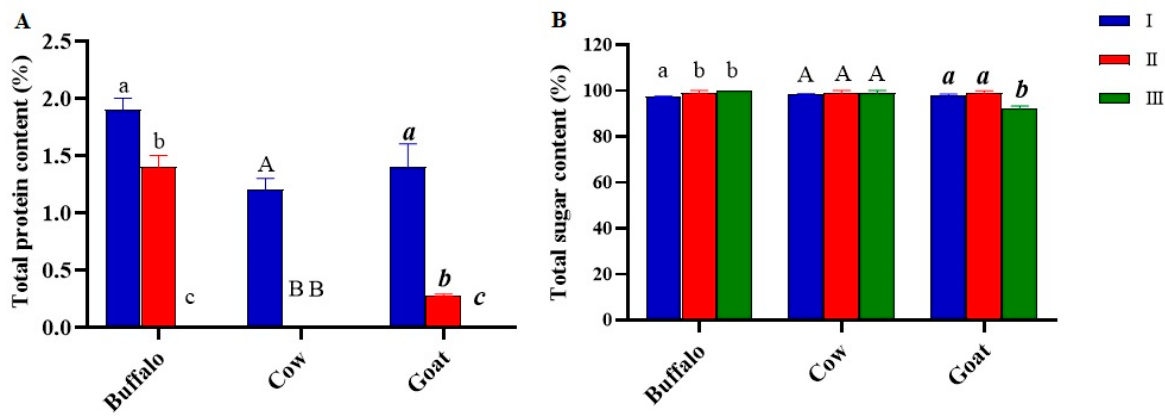
Figure 5. ( A ) Protein content (%) and ( B ) total sugar (%) of kefiran exopolysaccharide as influenced by different extraction methods including cold water (I), hot water (II), and mild heat-ultrasound